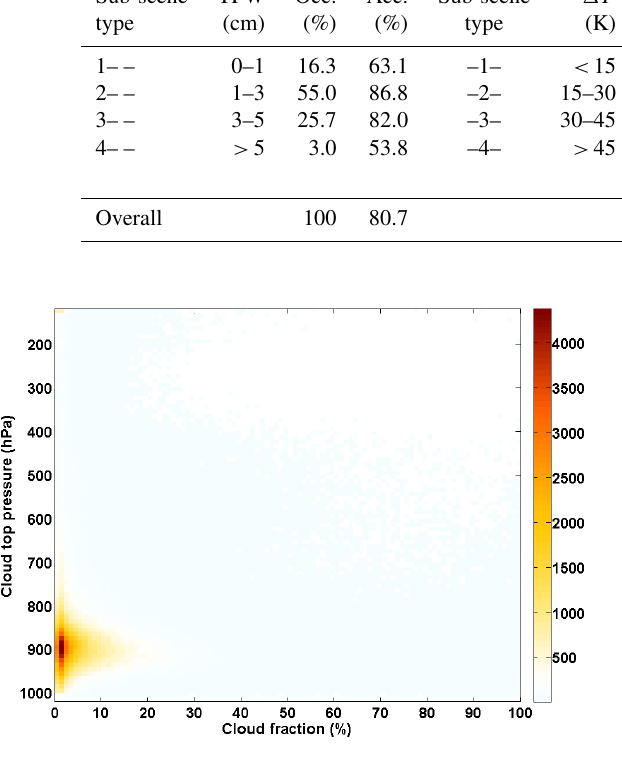
Figure 2. Number of AIRS footprints that are misclassified as clear- sky footprints as a function of cloud fraction and cloud top pres- sure. The cloud information is from the collocated CERES SSF data